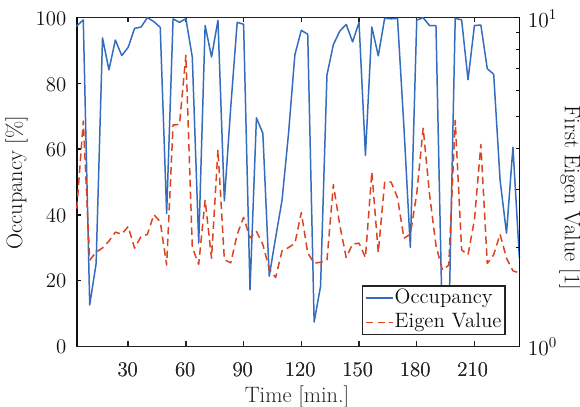
Figure 5. Occupancy rate and eigenvalue for 2016/72/00-04.